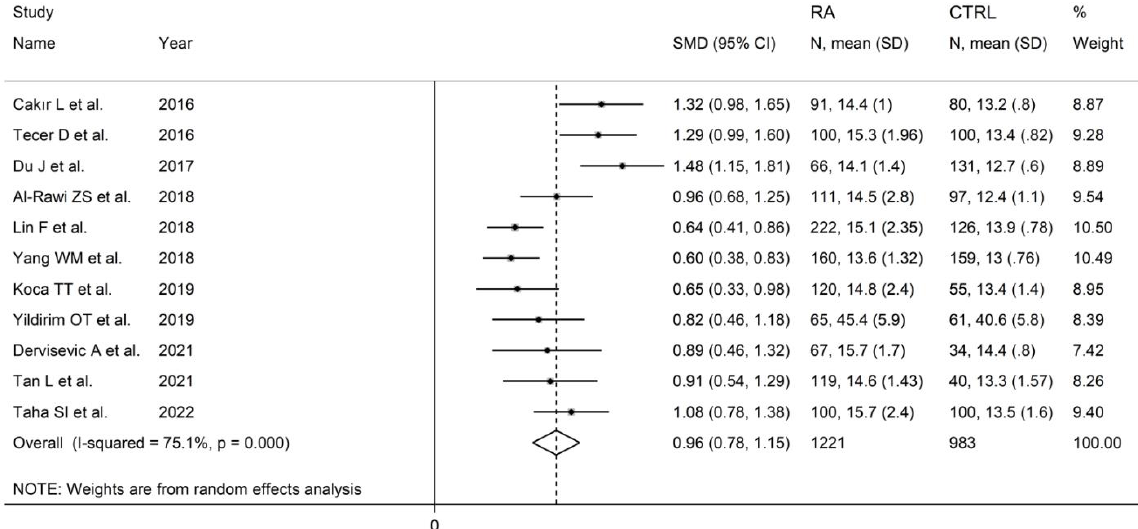
toid arthritis and healthy controls. arthritis and healthy controls.